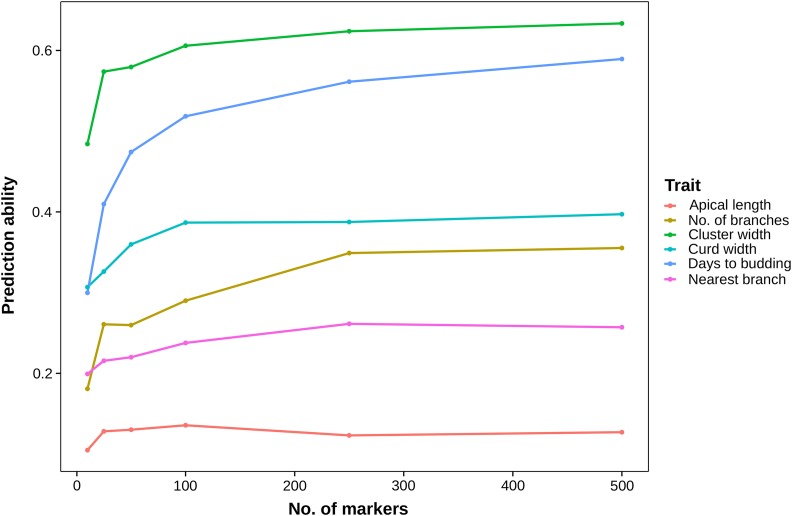
Effect of increasing the number of markers, included in a five-fold cross-validation with 10 replications using a standard GBLUP model, on prediction ability. Values represent averages of 100 runs. 10, 25, 50, 100, 250 and 500 markers, respectively, were sampled randomly for each run.